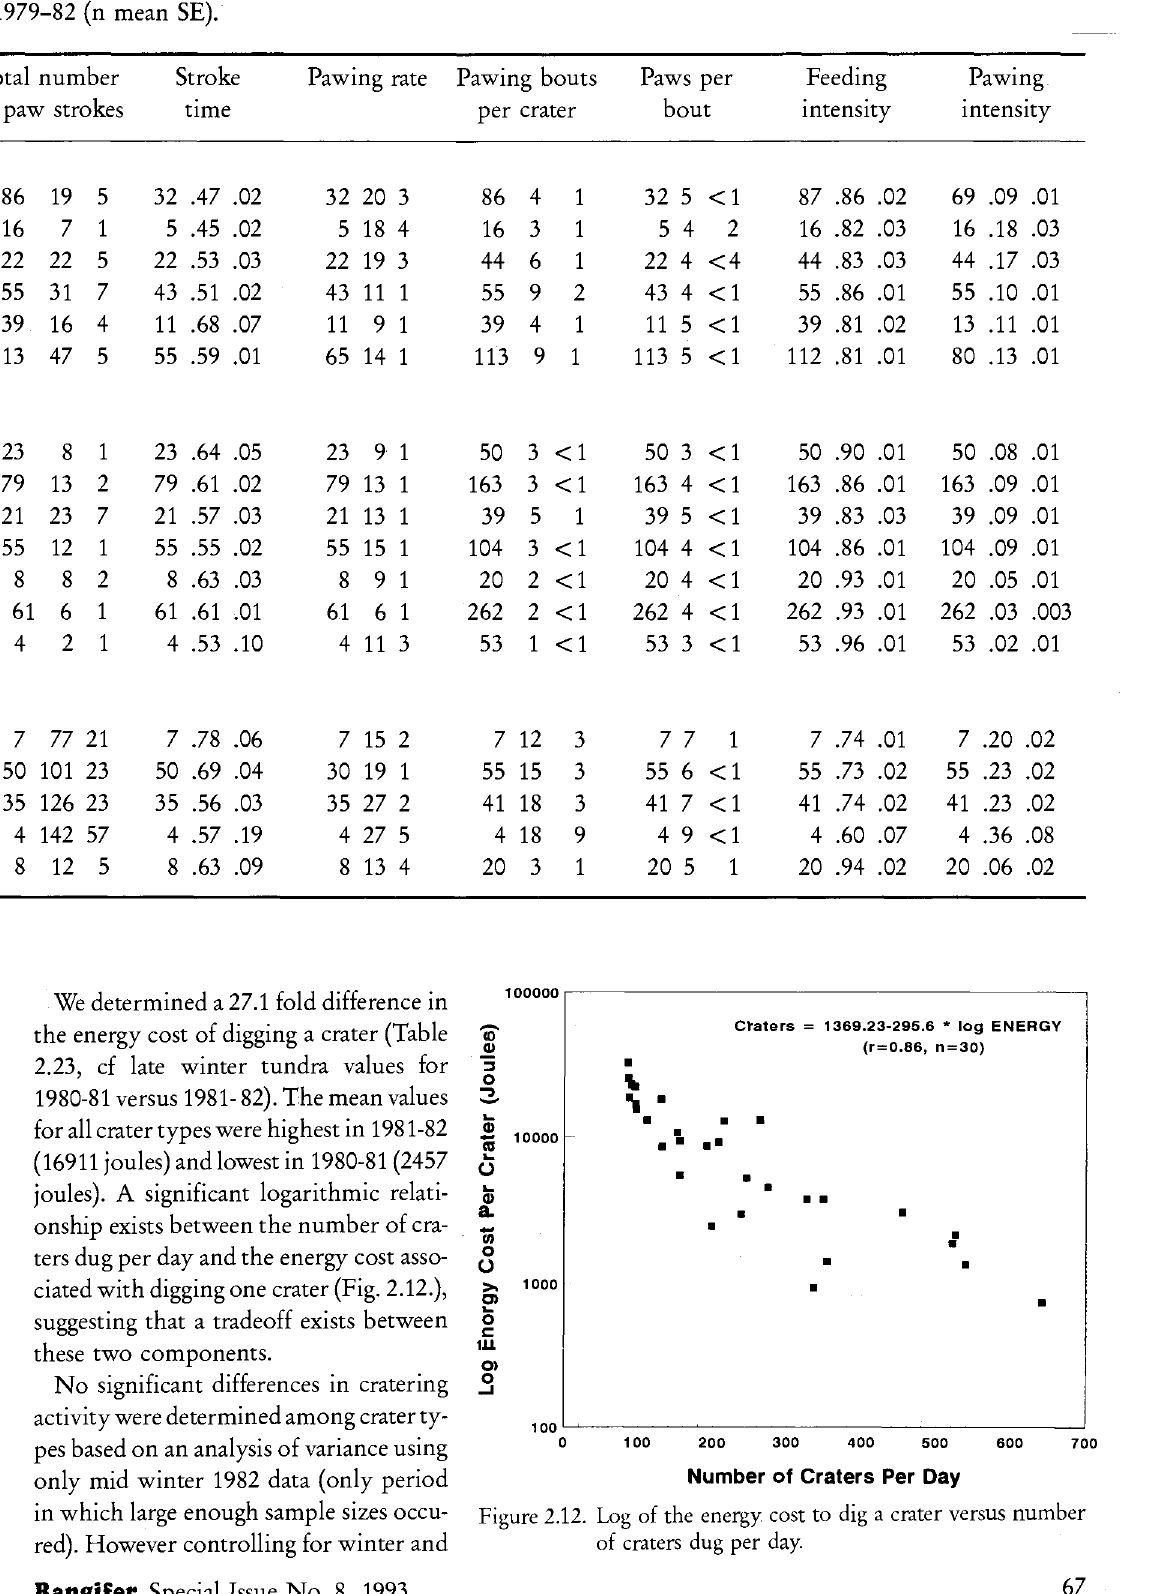
Figure 2.12. Log of the energy cost to dig a crater versus